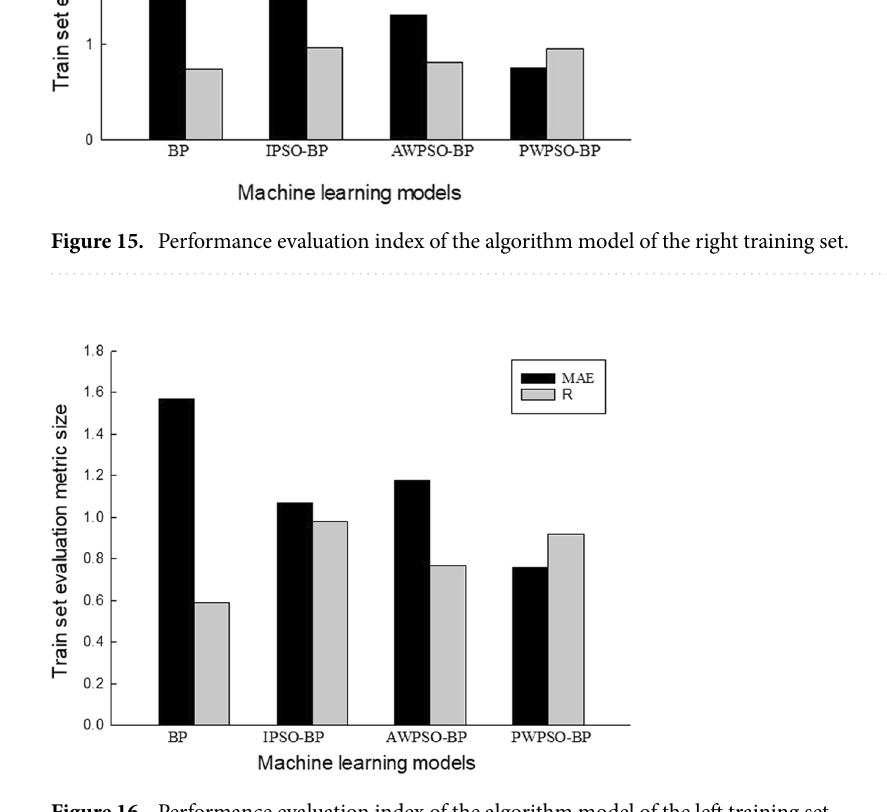
Figure 16. Performance evaluation index of the algorithm model of the left training